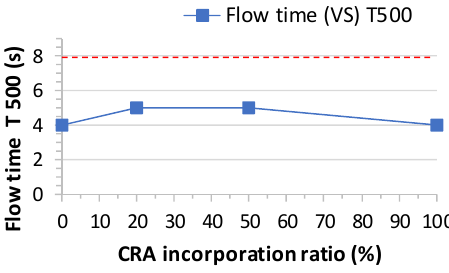
Figure 7. Flow time T 500 test results.